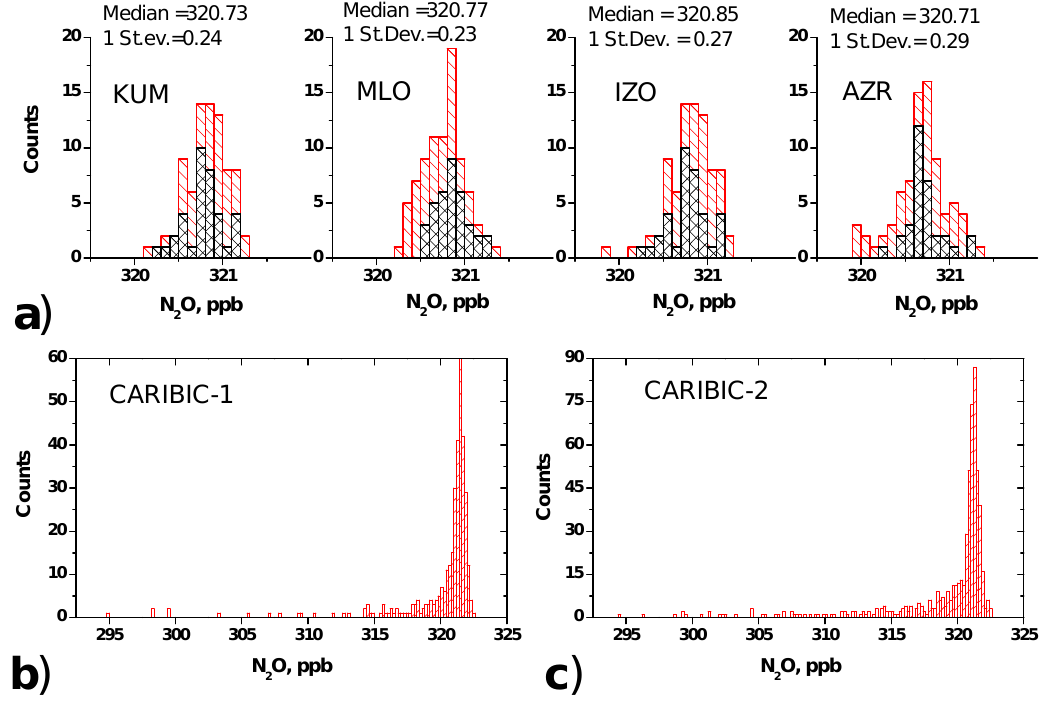
Fig. 4. (a) Distribution of de-trended, monthly mean N 2 O data for NOAA stations in the NH tropics, 1999 to 2002 (in red) and 2006 to 2008 (in black). The distributions have the same Median at 320.8ppb and very similar widths. (b–c) Distribution of ozone data and de-trended N 2 O data for CARIBIC-1 and CARIBIC-2. Majority of samples represent tropical free tropospheric and UT air masses and have N 2 O above 320.0ppb; the tailing to lower N 2 O values is due to the contribution of LMS air